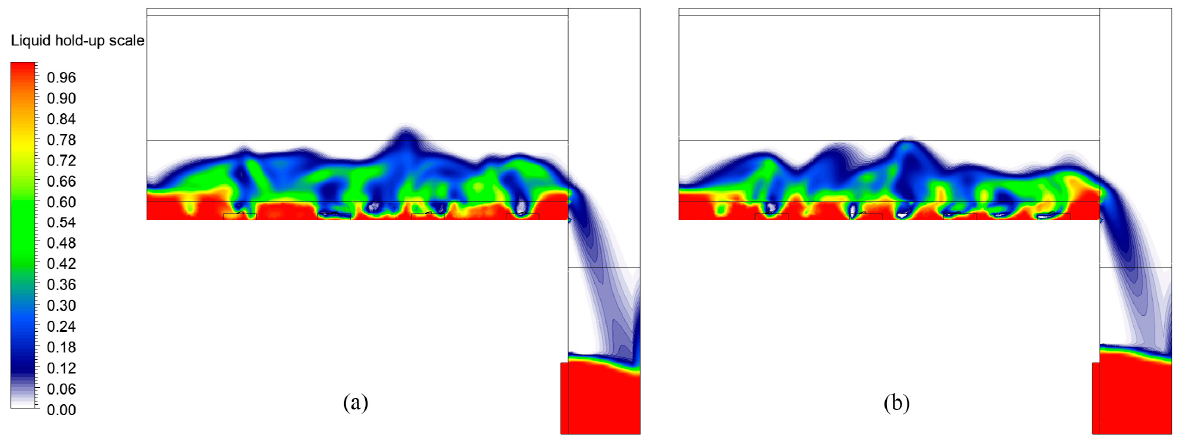
Figure 8. Liquid hold–up snapshots of the front view: ( a ) rectangular guided valve tray; ( b ) parabolic–